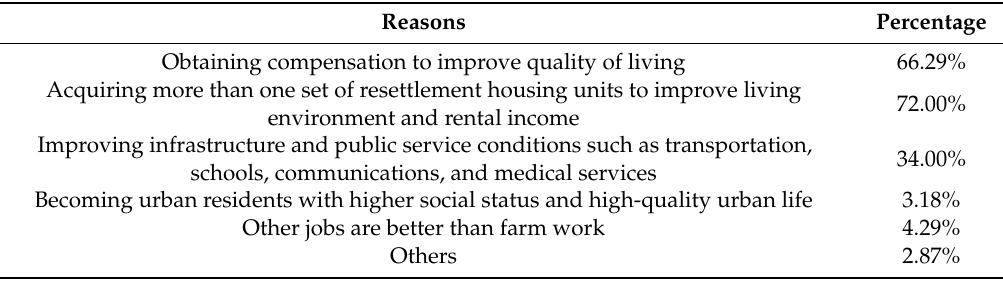
Table 6. Reasons for Accepting